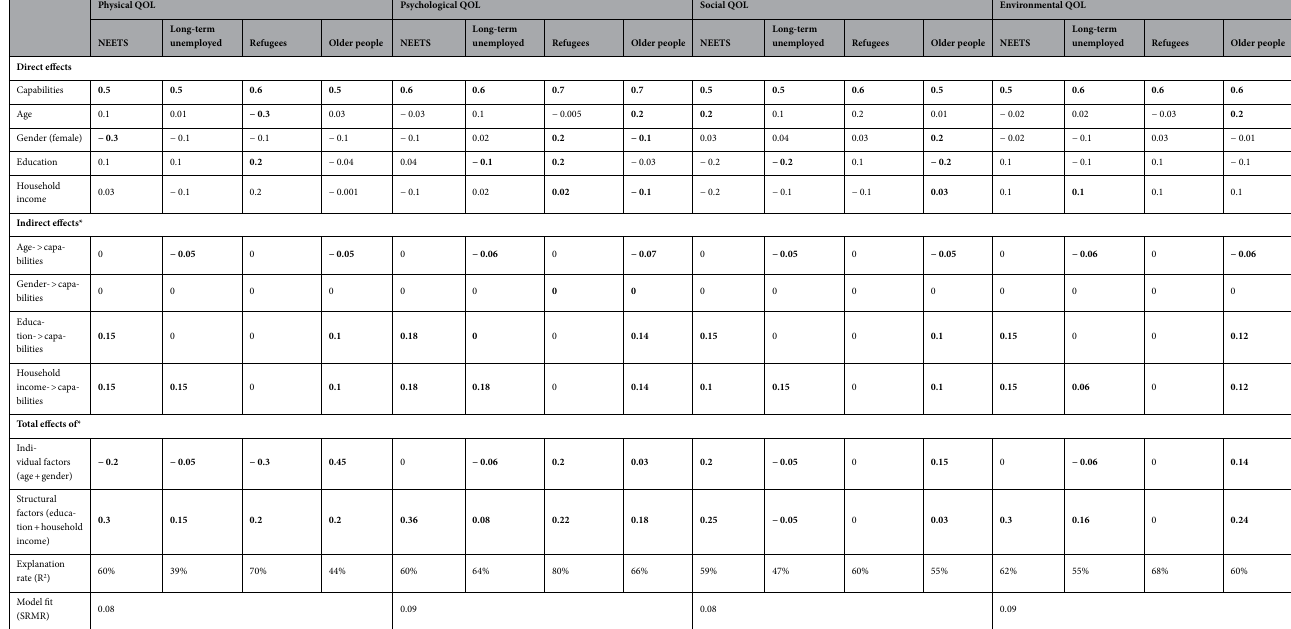
Table 3. Group differences in the associations of individual and structural factors as well as capabilities with dimensions of QoL, explanation rates (R2) and model fit index (SRMR), statistically significant (p <